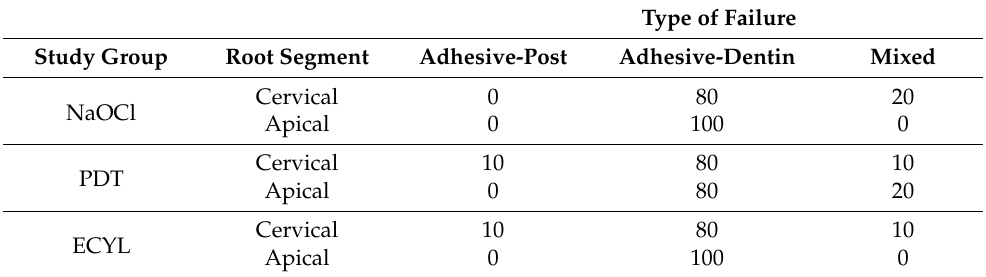
Table 2. Percentage distribution of interfacial failure types among the study groups.